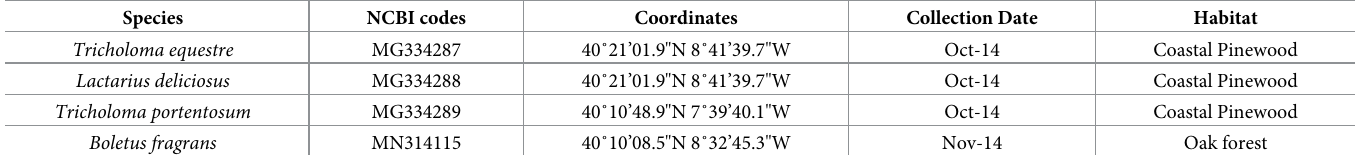
Table 1. NCBI accession number, geographic origin, collection date and habitat of the fungal species used in this study.